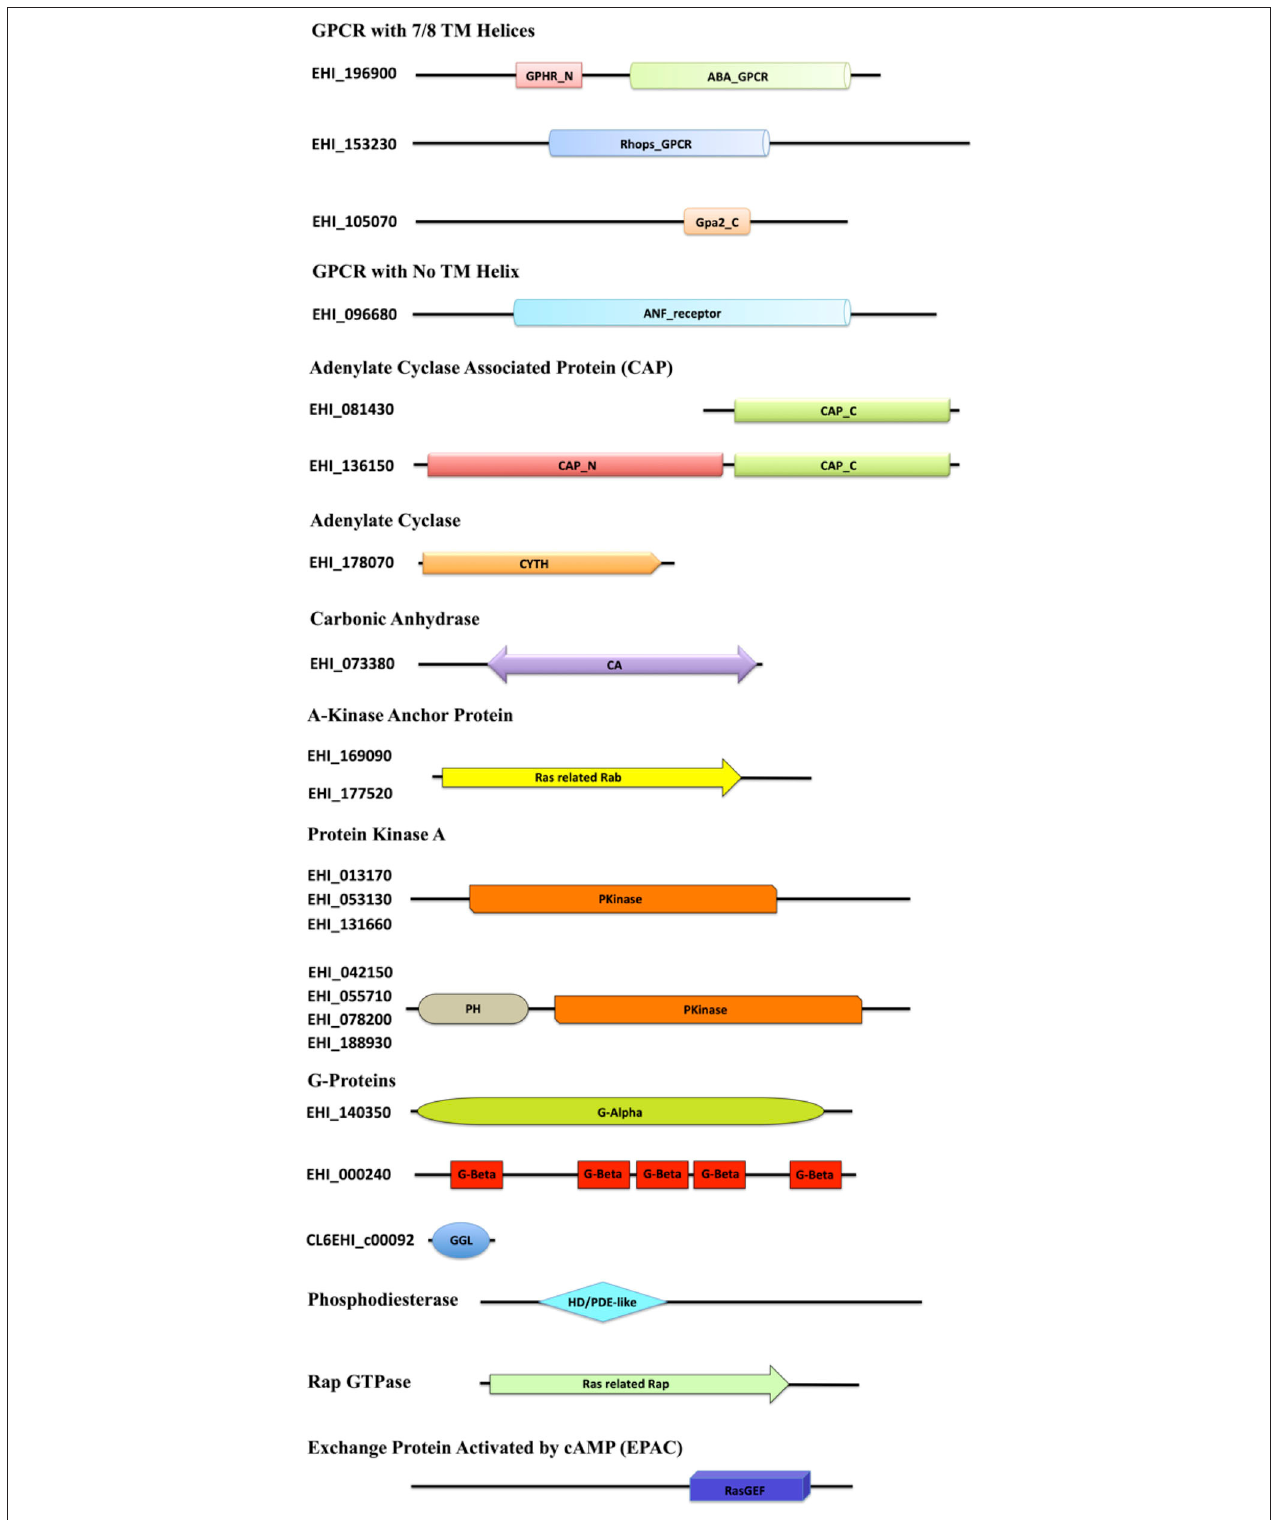
FIGURE 1 | Diagrammatic representation of the domain architecture of the cAMP signaling proteins from E. histolytica . The domain abbreviations used in the diagram are as follows: ABA_GPCR, abscisic acid G-protein-coupled receptor; GPHR_N, Golgi pH Regulator (GPHR) Family N-terminal; Rhops_GPCR, rhodopsin-like GPCR